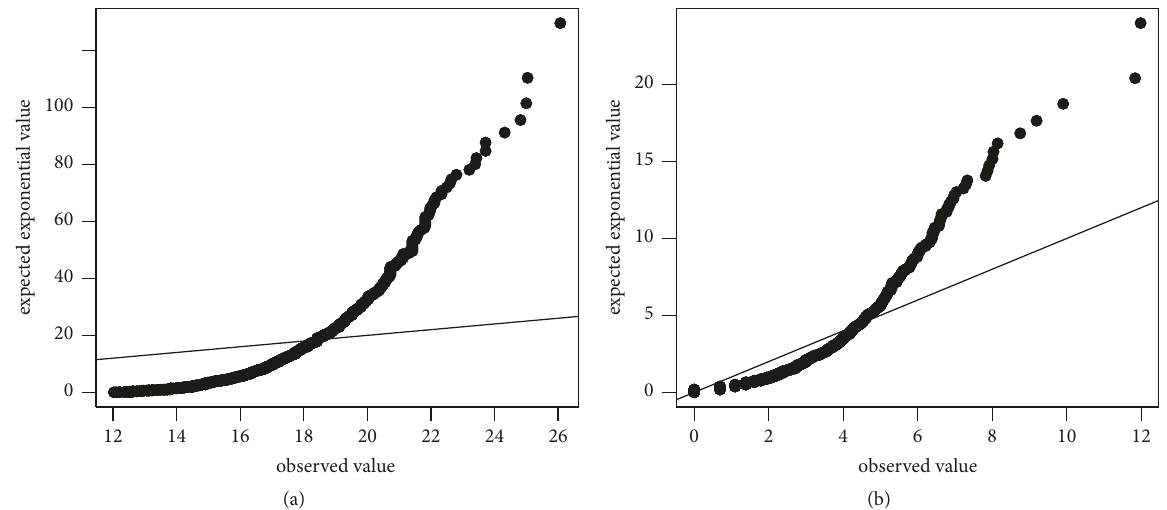
Figure 1: Exponential QQ plot of economic losses (a), exponential QQ plot of deaths